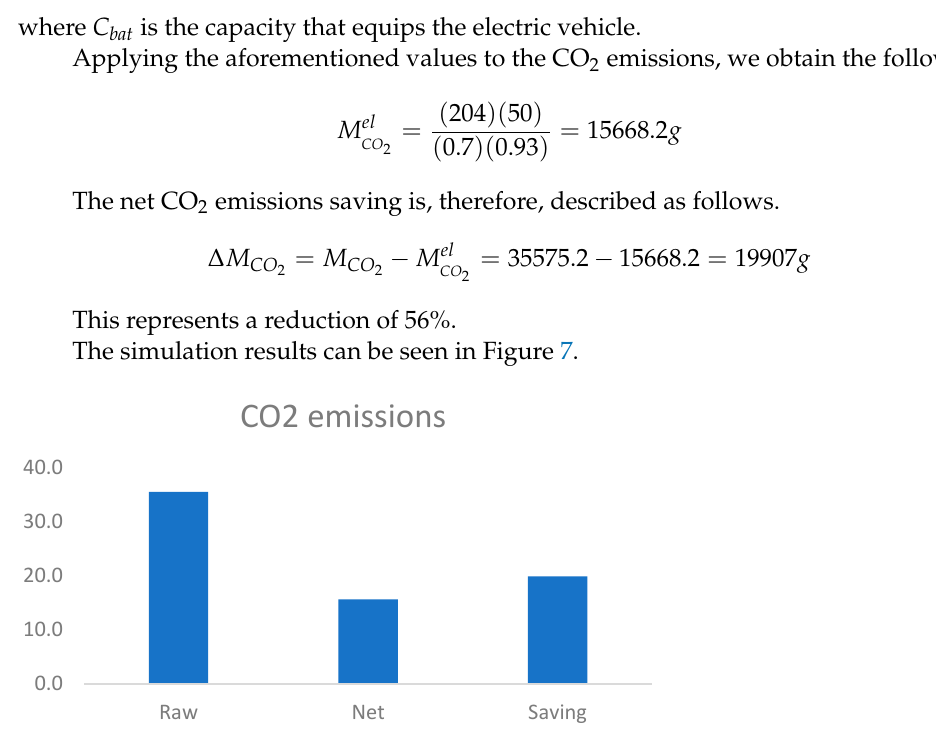
Figure 7. Simulation results of the CO 2 emissions.